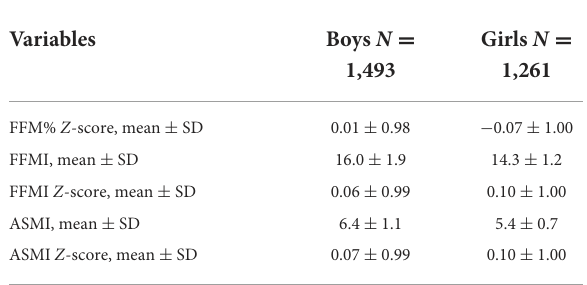
TABLE 1 Characteristics of participants in Tanner stage